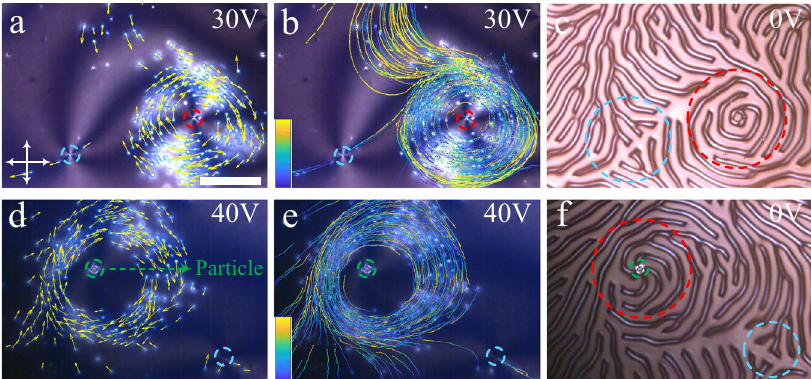
Fig. 10 Circular motion of directron fl ocks. Polarizing micrographs of circulating motion of directrons around ( a ) a s = + 1 defect at f = 100 Hz, U = 30 V and ( d ) a micro-particle at f = 60 Hz, U = 40 V with their velocities represented as yellow arrows. Polarizing micrographs of circulating motion of directrons around ( b ) a s = + 1 defect and ( e ) a micro-particle with their trajectories colored with time corresponding to the color bar. The color bars change linearly from ( b ) t = 0 s (dark blue) to t = 10 s (light yellow) and ( e ) t = 0 s (dark blue) to t = 8.6 s (light yellow), respectively. c , f Polarizing micrographs of the fi ngerprint textures at U = 0 V. Scale bar 100 μ m. The crossed polarizers are indicated as white arrows. The s = + 1 defects and s = − 1 defects are circled with red and blue dashed lines, respectively. The micro-particle is circled with a green